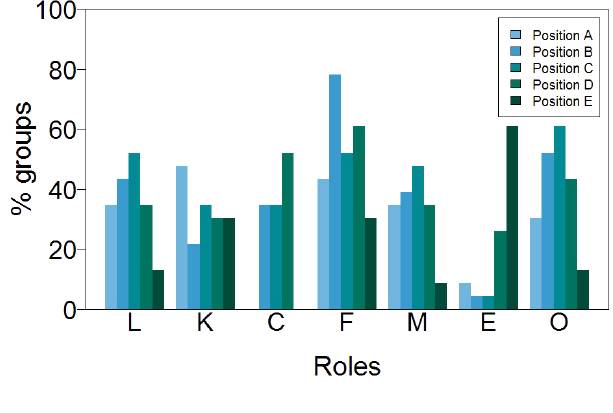
Fig. 5 . Percentage of groups in which a role is present by position. This figure emphasizes that the role of follower was most prevalent, and most followers occupied position B. It also shows that enforcers seldom occupied positions A, B, or C. As one would expect, enforcers tended to emerge in position E. L = leader, K = knowledge generator, C = connector, F = follower, M = moralist, E = enforcer, O = observer.